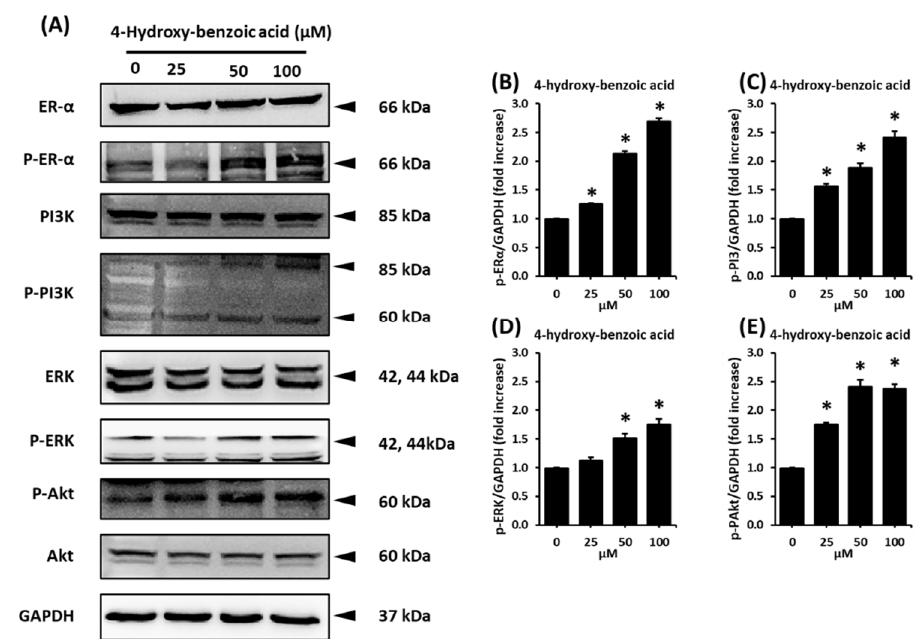
Figure 5. ( A ) Effects of 4-hydroxy-benzoic acid ( 2 ) on the protein expression levels of p-ERK, ERK, p-PI3K, PI3K, p-AKT, AKT, p-ER α , ER α , and GAPDH in MCF-7 cells treated or untreated with 25, 50, and 100 µM 4-hydroxy-benzoic acid ( 2 ) for 96 h. ( B – E ) The bar graph presents the densitometric quantification of the western blot bands. * Significant difference between the treated cells with 4-hydroxy-benzoic acid ( 2 ) and untreated cells. Significant difference between the treated cells with ICI and without ICI at the same concentration of the sample ( n = 3 independent experiments, p < 0.05, Kruskal–Wallis non-parametric test) ( n = 3 independent experiments, p < 0.05, Kruskal–Wallis non-parametric test). Data are represented as the mean ± SEM.